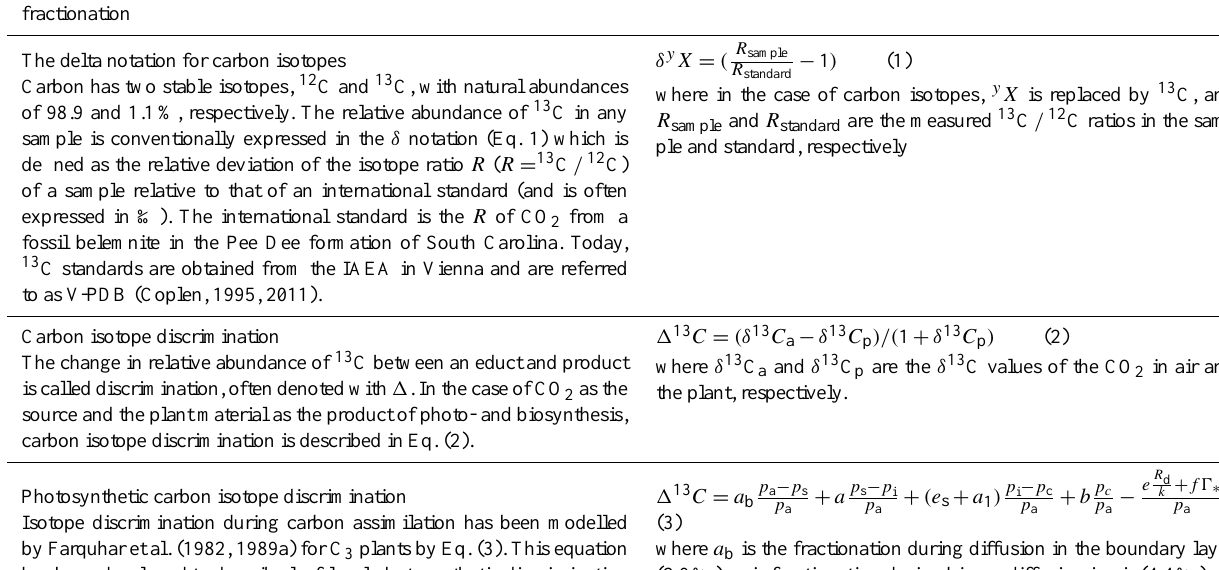
Table 1. Introduction to terms and equations of carbon isotopes, photosynthetic discrimination and post-carboxylation fractionation.